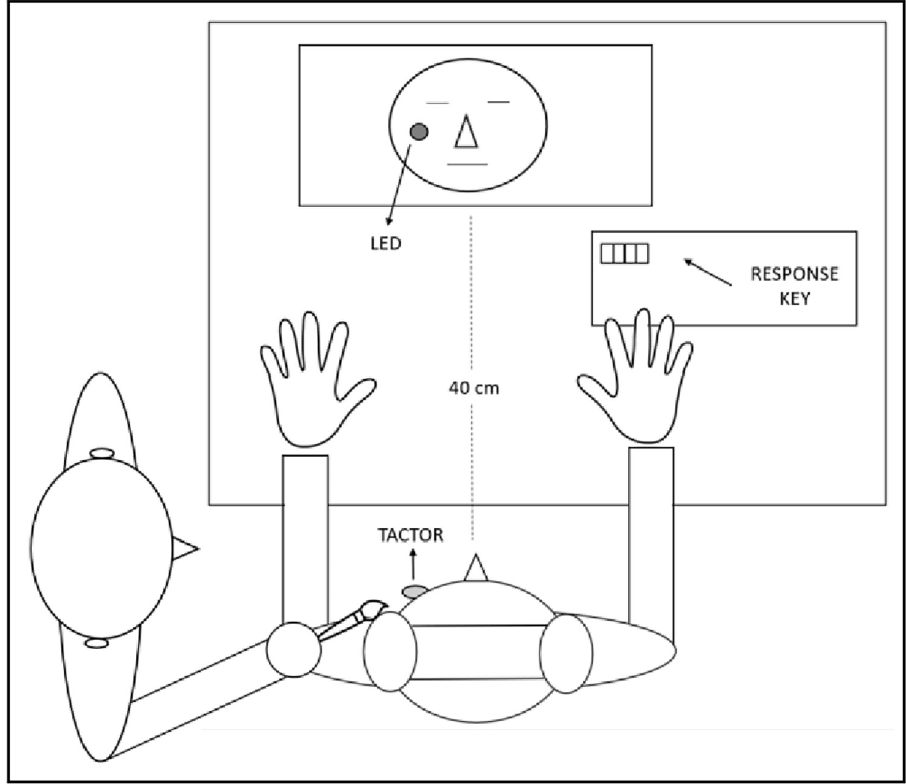
Fig 1. Schematic depiction of the experimental set-up during the SSDT. The experimenter (left) delivered the touch manipulation to the participant (right) between the first (Pre) and the second (Post) repetition of the SSDT.